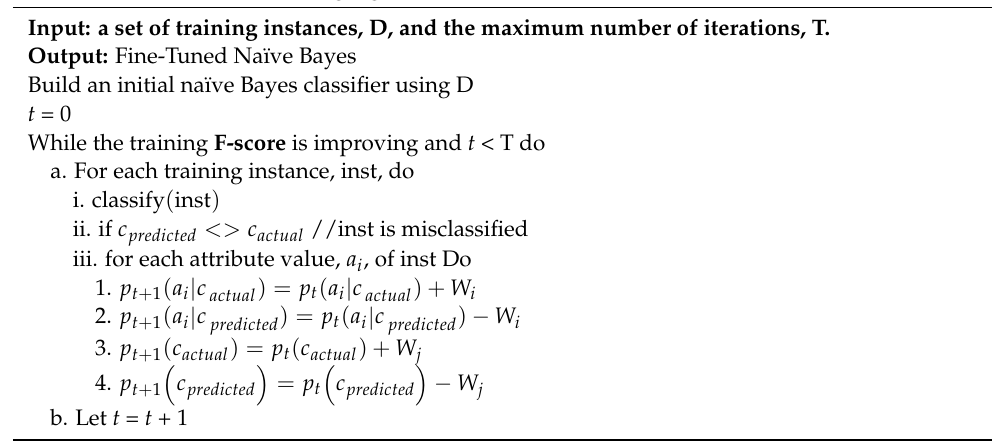
Algorithm 1: CHNB fine tuning